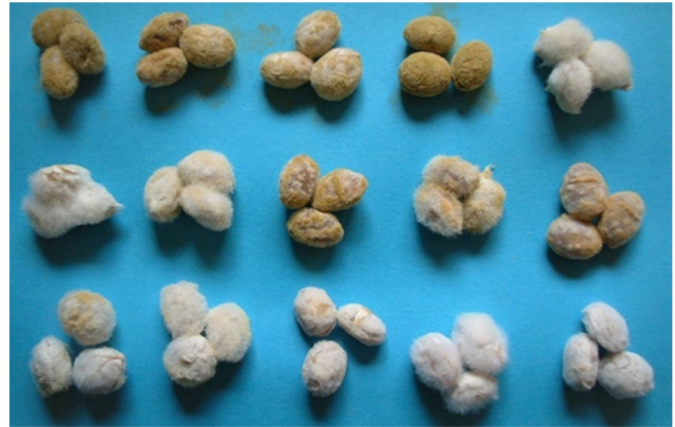
Figure 4. Differences in growth rate on steamed rice: (- • -) Aspergillus oryzae W-20; (- oryzae W-52; (- (cid:78) -) Aspergillus oryzae S-03; (- (cid:52) -) Aspergillus sojae No.9; (- (cid:3) -) Aspergillus luchuensis SH35; hr hour.